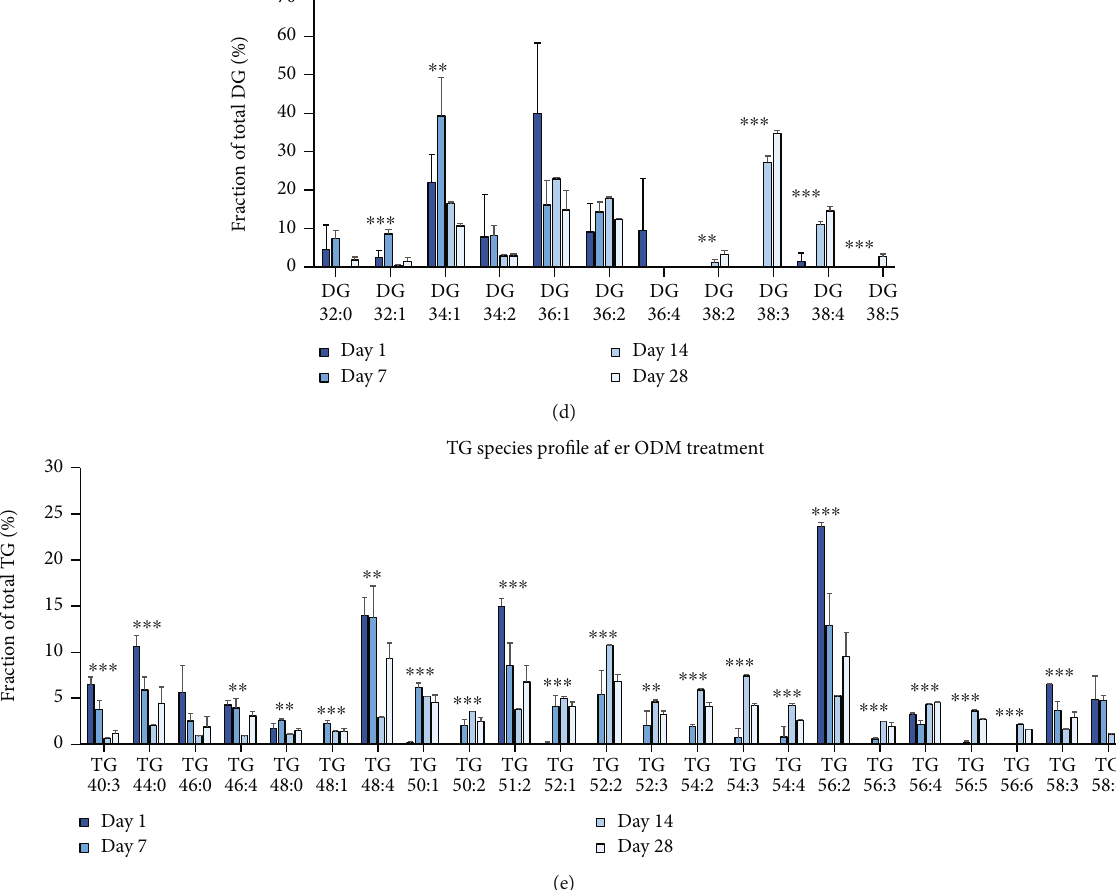
Figure 6: Regulation of storage lipids and diacylglycerol during osteogenic di ff erentiation of DFCs. DFCs were cultured in osteogenic di ff erentiation medium (ODM), BMP2 di ff erentiation medium, or control medium (DMEM) for one, seven, 14, and 28 days before the lipidome was analyzed by MS. (a – c) The line charts show the fraction of diacylglycerols (DG, a), triacylglycerols (TG, b), and cholesteryl esters (CE, c). Data points show means ± standard deviation , and Student ’ s t -test was performed to compare di ff erentiation medium with control medium at the same time point. ∗ p < 0 : 05 , ∗∗ p < 0 : 01 , ∗∗∗ p < 0 : 001 . Asterisks relate to the di ff erentiation medium with data points and line in same color. (d, e) Furthermore, the composition of DG species (d) and TG species (e) in cells treated with ODM at the di ff erent time points is shown. Only species with an abundance of more than 2% for at least one time point are shown as means + standard deviation , and one-way ANOVA was performed to determine signi fi cant di ff erences in the fraction of a speci fi c species at di ff erent time points. ∗∗ p < 0 : 01 , ∗∗∗ p < 0 : 001